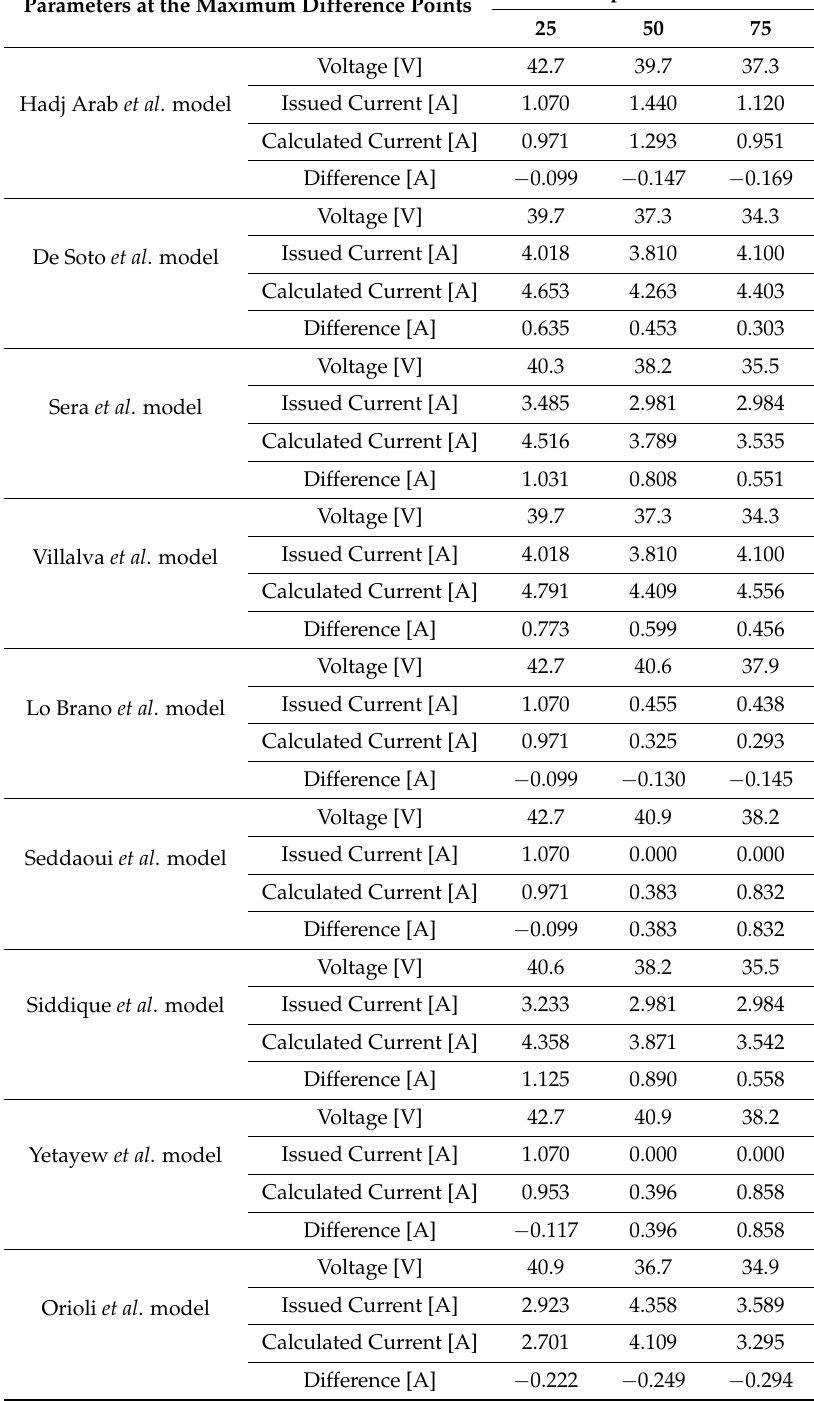
Table 10. Maximum current differences between the calculated and the issued I-V characteristics of Sanyo HIT-240 HDE4, at irradiance G = 1000 W/m 2